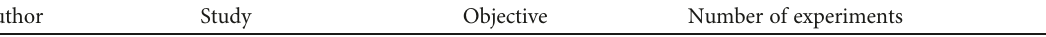
Table 1: Publication